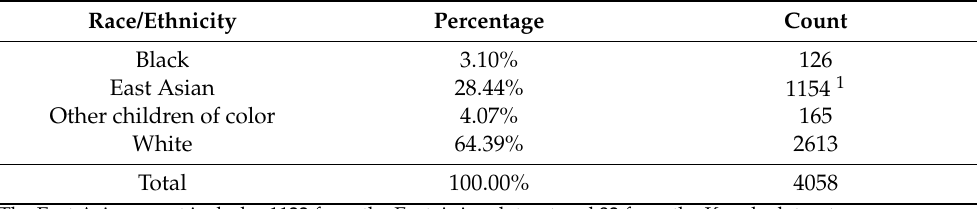
Table 1. Race distribution in the combined dataset. Race/Ethnicity Percentage Count Black 3.10% 126 East Asian 28.44% 1154 1 Other children of color 4.07% 165 White 64.39% 2613 Total 100.00%